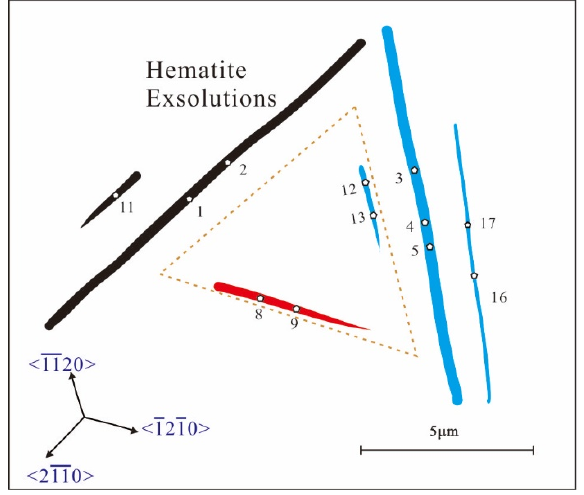
Figure 6. Outline traced on exsolutions from the SEM-BSE. The orange line triangle is equilateral. The exsolutions are approximately parallel to each side of the triangle.